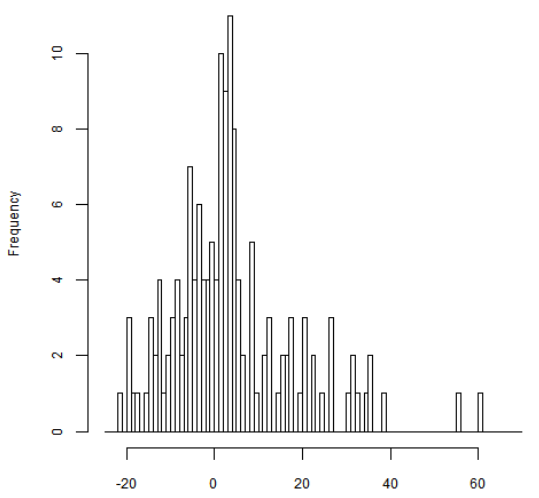
Figure 6. Frequency plot of differences between SRTM90 heights resampled by natural neighbour technique (90_n) and UAV based heights. Width of each bar is 1m.